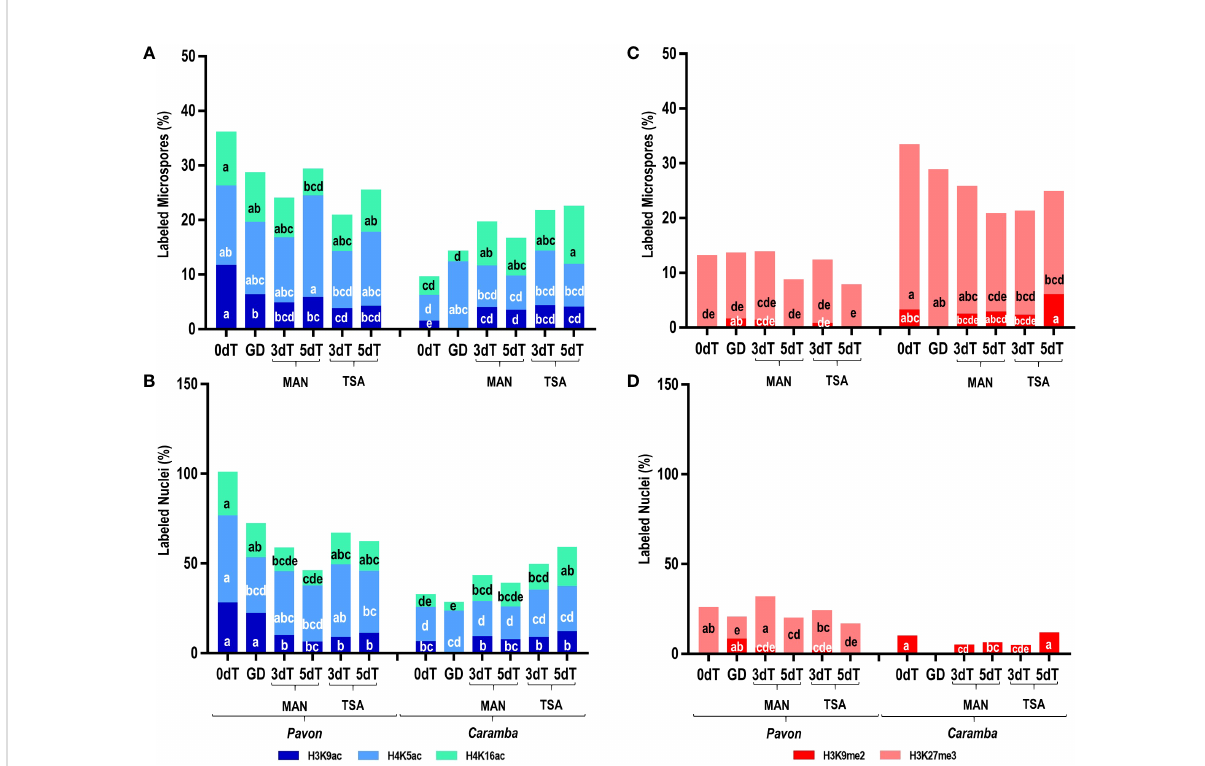
FIGURE 2 Effect of MAN and TSA on histone PTMs. (A, B) Percentage of labeled microspores and nuclei, respectively, with the acetylation marks H3K9ac (dark blue), H4K5ac (light blue), H4K16ac (green). (C, D) Percentage of labeled microspores and nuclei, respectively, with the methylation marks H3K9me2 (red), H3K27me3 (pink). Microspores before stress treatment (0dT), microspores under gametophyte development (GD), microspores after 3 and 5 days with mannitol treatment (3dT-MAN, 5dT-MAN) and after 3 and 5 days with mannitol plus TSA treatment (3dT-TSA, 5dT-TSA) from Pavon (on the left) and Caramba (on the right). Percentages of labeled microspore and nuclei with the same letter within each epigenetic mark are not signi fi cantly different (P ˂ 0.05) according to the Duncan